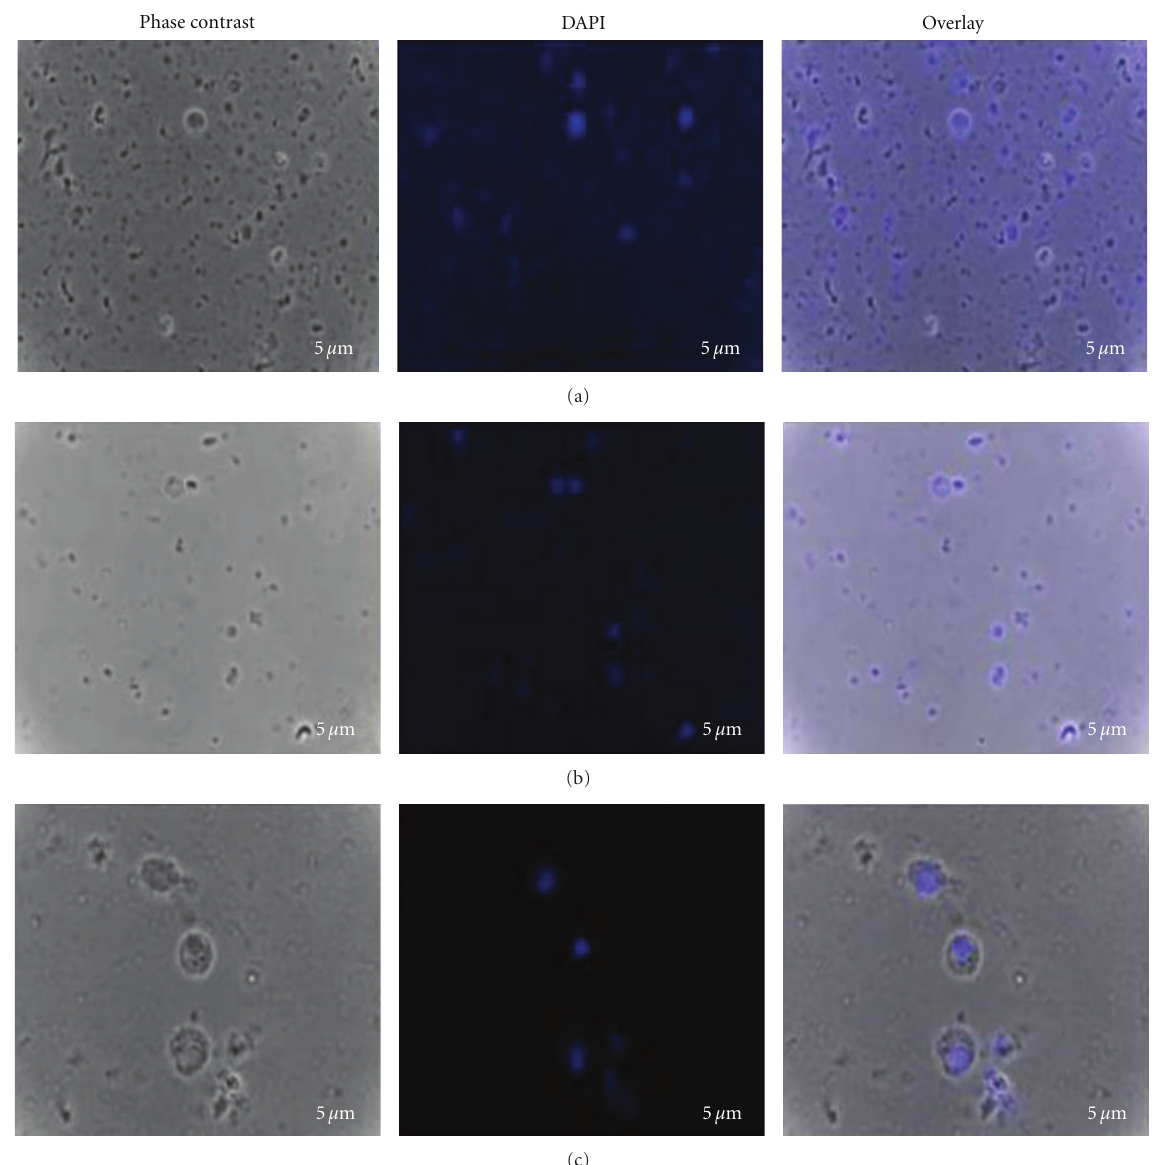
Figure 2: Disruption of parasite tissue and staining of primary cells. After isolation, primary cells were fixed and nuclei were stained with DAPI. Composed figure depicts stained cells with DAPI (produces blue color) of Taenia solium , Taenia crassiceps , and Trichinella spiralis